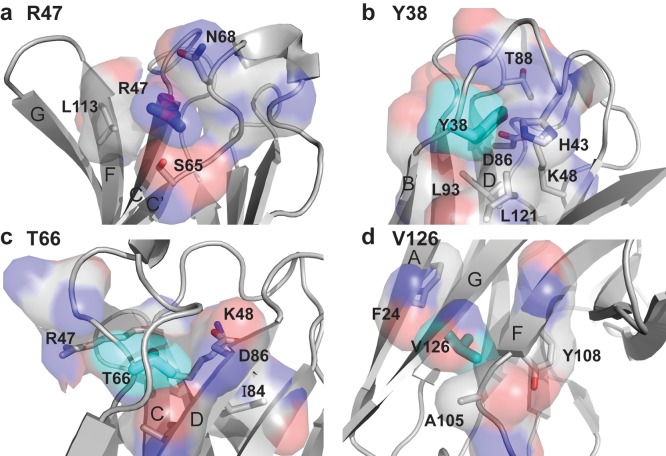
Packing neighbors for the TREM2 AD risk variant R47 and the TREM2 NHD mutants Y38, T66, and V126.(a) Packing environment for surface residue R47 (magenta carbon sticks and surface). The gray carbon surface shows all residues that contact R47. Residues whose side chains make Van-der Waals contacts with the R47 side chain are shown as sticks and are labeled. (b) Packing environment for the buried residue Y38 (cyan carbon sticks and surface). The gray carbon surface shows all residues that contact Y38. Residues whose side chains make Van der Waals contacts with the Y38 side chain are shown as sticks and are labeled. (c) Packing environment for the buried residue T66 (cyan carbon sticks and surface). The gray carbon surface shows all residues that contact T66. Residues whose side chains make Van-der Waals contacts with the T66 side chain are shown as sticks and are labeled. (d) Packing environment for buried residue V126 (cyan carbon sticks and surface). The gray carbon surface shows all residues that contact V126. Residues whose side chains make Van der Waals contacts with the V126 side chain are shown as sticks and are labeled.